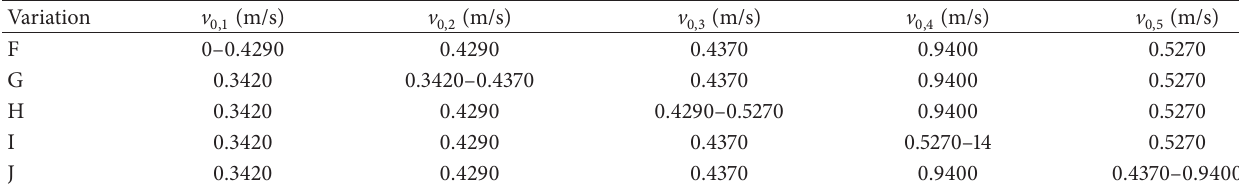
Figure 4: Characteristics of flow velocity at Katulampa with respect to the first variation of initial flow speed (a) A, (b) B, (c) C, (d) D, and (e) E. Table 3: Second variation of initial flow